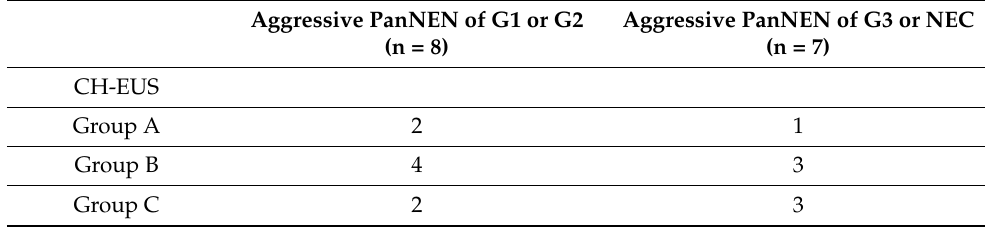
Table 5. Characteristics of the contrast-enhancement patterns of aggressive PanNENs on